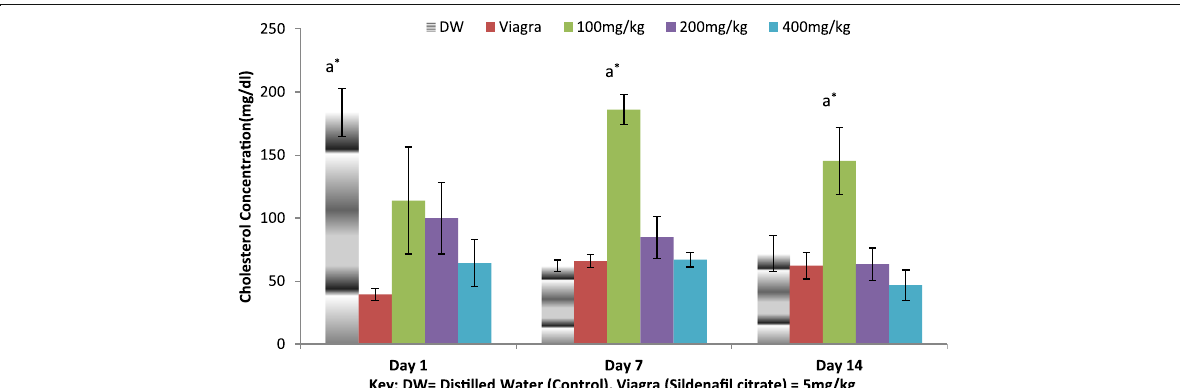
Fig. 7 Effect of ethanol extract of A. barbadensis root on cholesterol concentration of male rats. Bars with unlike letters are significantly different; bars with letters are significantly different from bars without letters while those with no letters are not significantly different from each other on each day. Bars with different numbers for the same dose group at different days are significantly different while those without numbers are not significantly different. All values are expressed as Mean ± SEM; n = 5;** P < 0.01; * P <